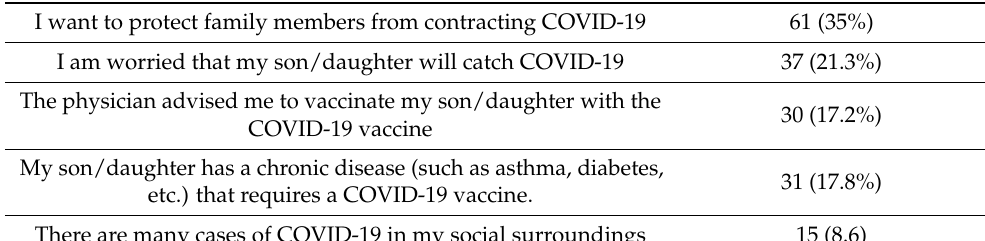
Table 5. Reasons behind parents willing to vaccinate their children n=